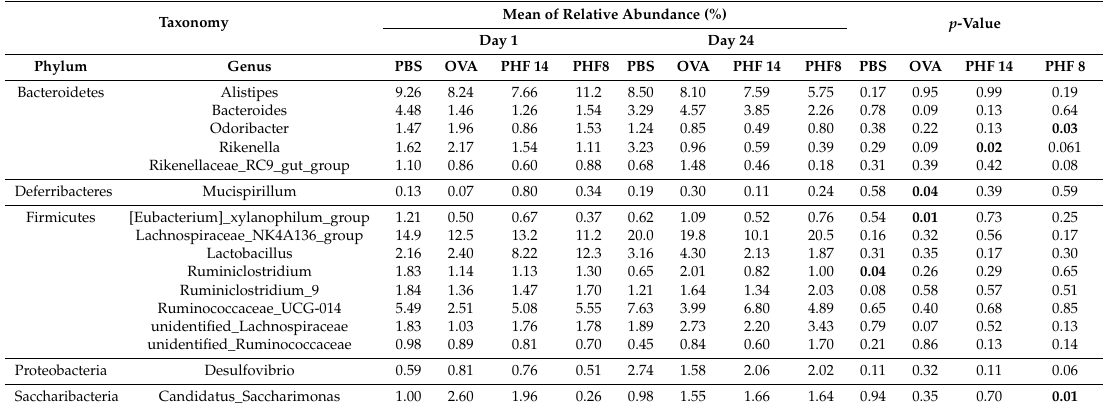
Figure 4. Effects of PHF treatment on gut microbial community structure at the phylum and genus levels. Stool samples were collected on day 1 before sensitization and on day 24 before sacrifice. ( A ) Relative Bacteroides/Firmicutes ratio in stool samples on day 24. ( B – G ) Percentage change in absolute abundance in the phyla of Bacteroidetes, Firmicutes, Saccharibacteria, Proteobacteria, Deferribacteres, and Cyanobacteria, respectively. ( H – K ) Percentage change in absolute abundance in the genera of Butyricicoccus, Eubacterium nodatum, Lachnospiraceae UCG-006 and Candidatus Saccharimonas, respectively. Results are shown in bar charts with mean + SEM. ( n = 4). * p < 0.05, ** p < 0.01 when compared with the OVA control group. PBS: healthy control; OVA: OVA-induced allergic asthmatic control; PHF14: mice with 14-day PHF treatment; PHF8: mice with 8-day PHF treatment; D1 and D24: day 1 and day 24, respectively. Table 3. Mean of relative abundance of predominating microbes (with relative abundance > 1% at any sample) at the genus level in stool samples on day 1 and day 24. p -values of paired t-test refer to comparison against the relative abundance on day